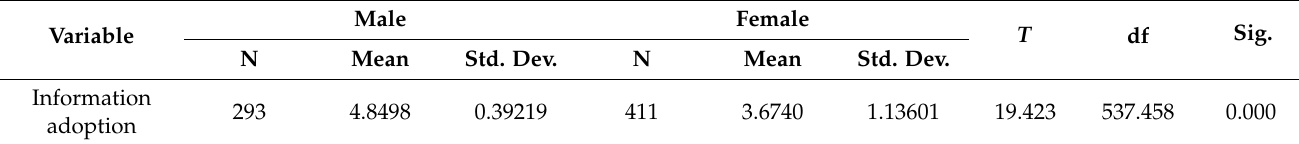
Table 8. The t -test of the respondents’ information adoption (IA) attributed to gender.